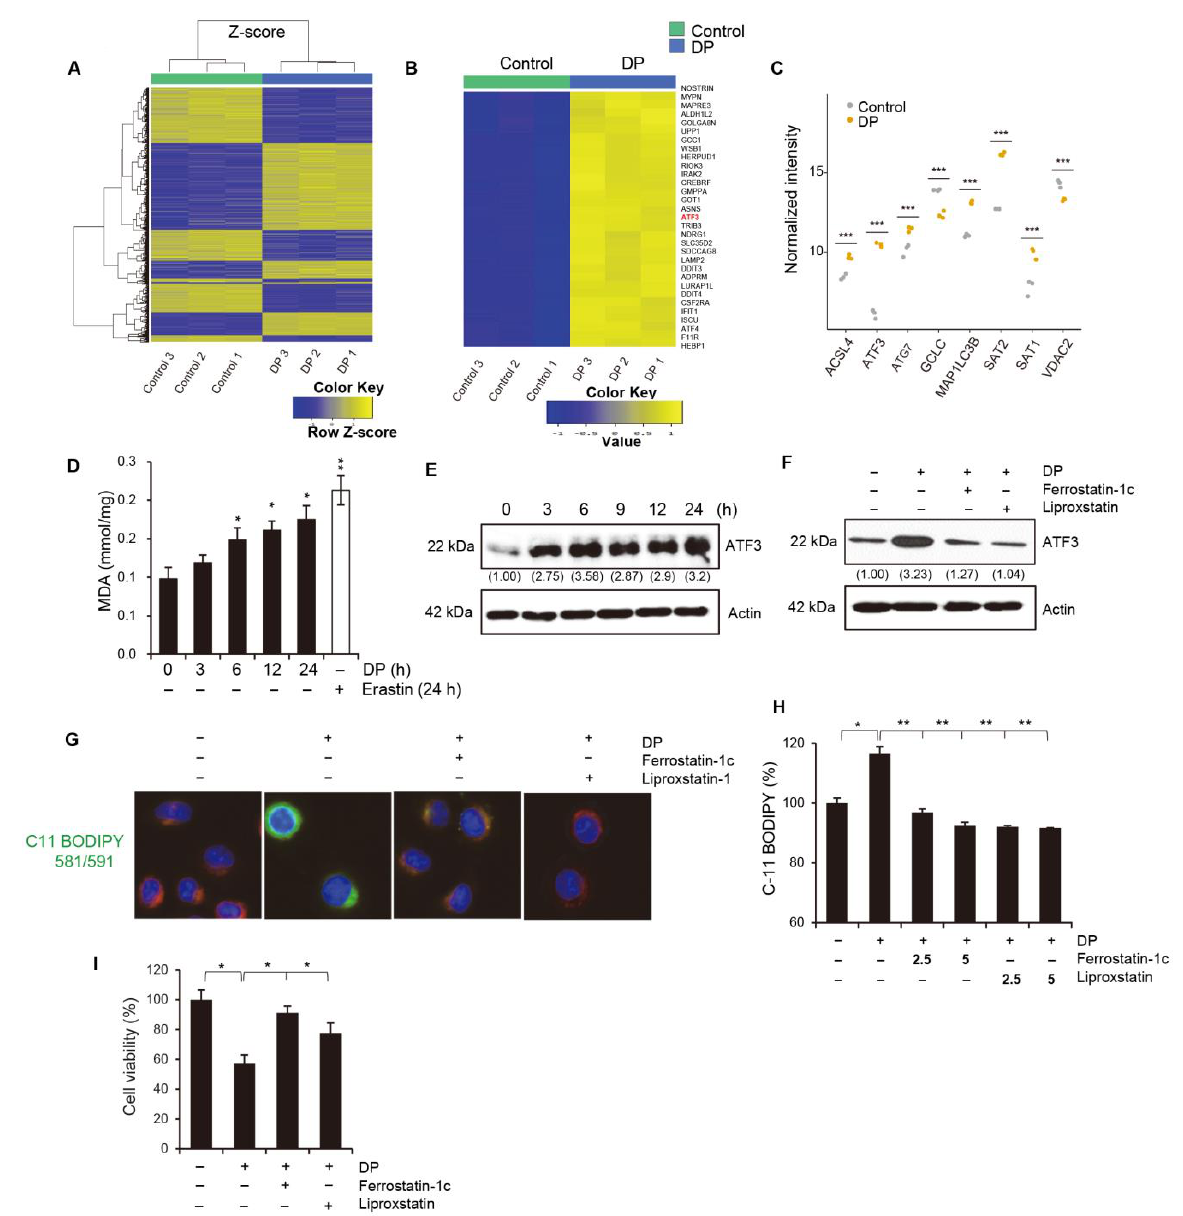
Figure 8. ATF3 is a candidate major gene in DP-induced ferroptosis. ( A – C ) Microarray data from A549 cells treated with DP for three independent experiments. ( D ) A549 cells were treated with 40 µM DP for the indicated time, and malondialdehyde (MDA) was measured. A ferroptosis inducer, 10 µM erastin, was used as a positive control. ( E ) A549 cells were treated with 40 µM DP for the indicated time and western blotting was performed to assess ATF3 expression. ( F ) Cells were treated with 40 µM DP for 24 h with 1 h pretreatment with 5 µM ferrostatin-1 and 5 µM liproxstatin-1. Western blotting was performed to assess ATF3 expression. Actin was used as a loading control. Numbers indicate the expression levels of each protein relative to actin. ( G , H ) A549 cells were treated with 40 µM DP for 24 h with 1 h pretreatment with 5 µM ferrostatin-1 and 5 µM liproxstatin- 1. Cells were assessed for lipid peroxidation using the lipophilic redox-sensitive dye C11-BODIPY 581/591, which shifts fluorescence from red to green in response to oxidation. BODIPY fluorescence intensity was determined by using a fluorescence microscope ( G ) and flow cytometry ( H ). ( I ) A549 Cells were treated with 40 µM DP for 24 h with 1 h pretreatment with 5 µM ferrostatin-1 and 5 µM liproxstatin-1. Cell viability was measured by the MTT assay. All data are expressed as the mean ±